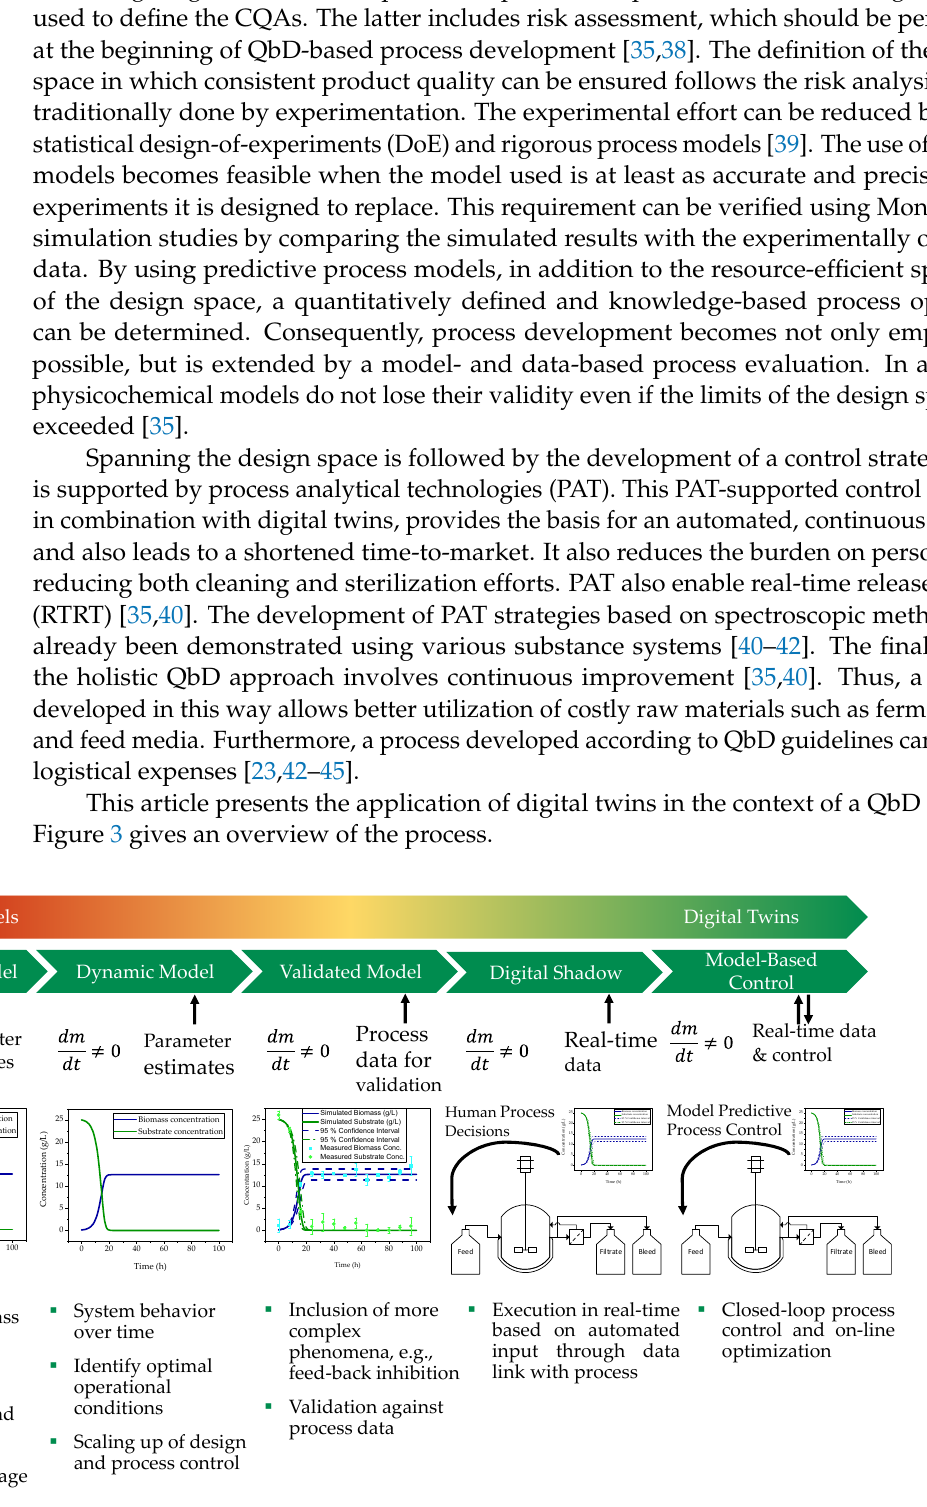
Figure 1. Levels of a digital twin, starting from a steady-state model, over a dynamic model, a validated model, and a digital shadow to a model-based control.